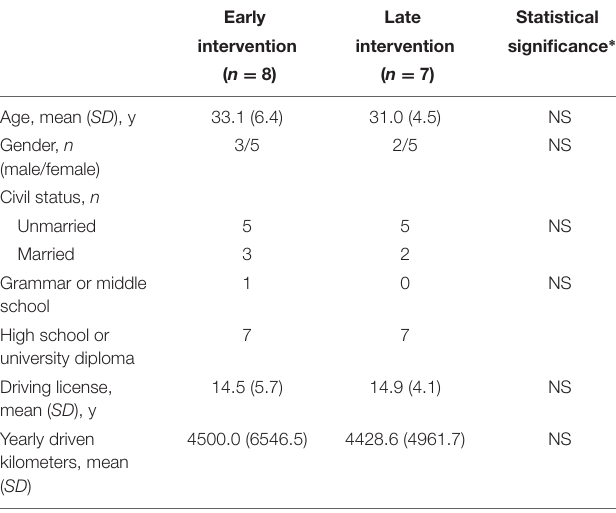
TABLE 1 | Demographic variables and driving history, separated for early and late intervention